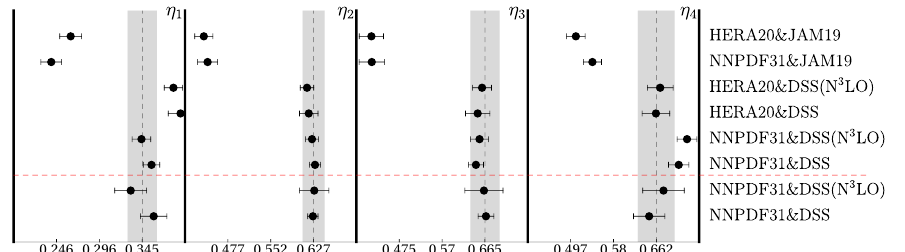
Figure 10 . Comparison of NP parameter for unpolarized TMDFF extracted in di(cid:11)erent (cid:12)ts. The values above the red-dashed line are extracted in (cid:12)t of SIDIS data with (cid:12)xed TMD evolution and TMDPDF, see table 6. The values below the red-dashed line are extracted in global (cid:12)t of DY and SIDIS data, see table 9. The vertical dashed lines and gray boxes correspond to average mean and standard deviation of the results of the global (cid:12)t. The input collinear distributions are marked in the right